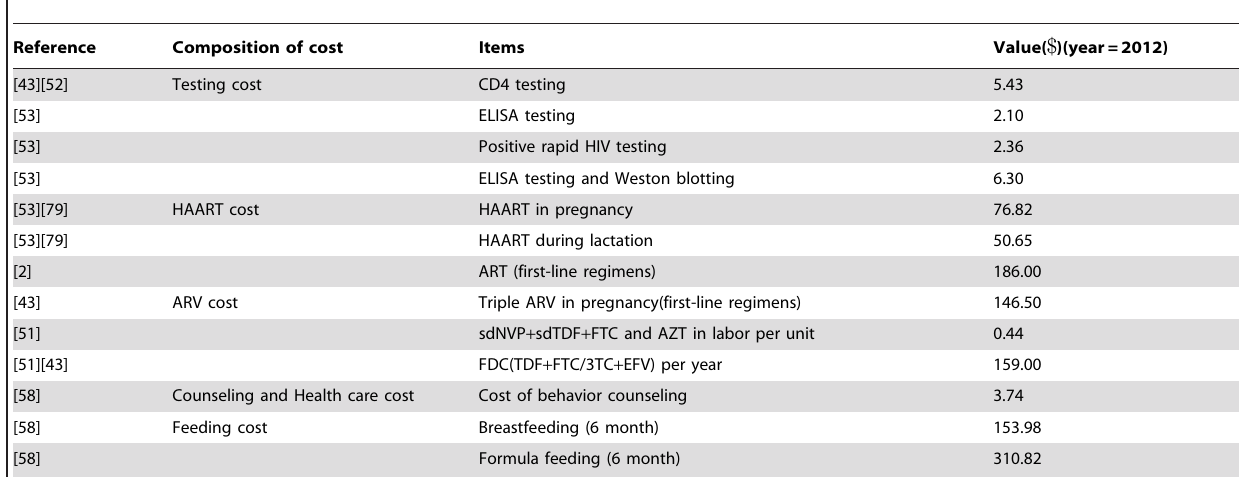
Table 2. References and input cost estimates for the decision analytic model.